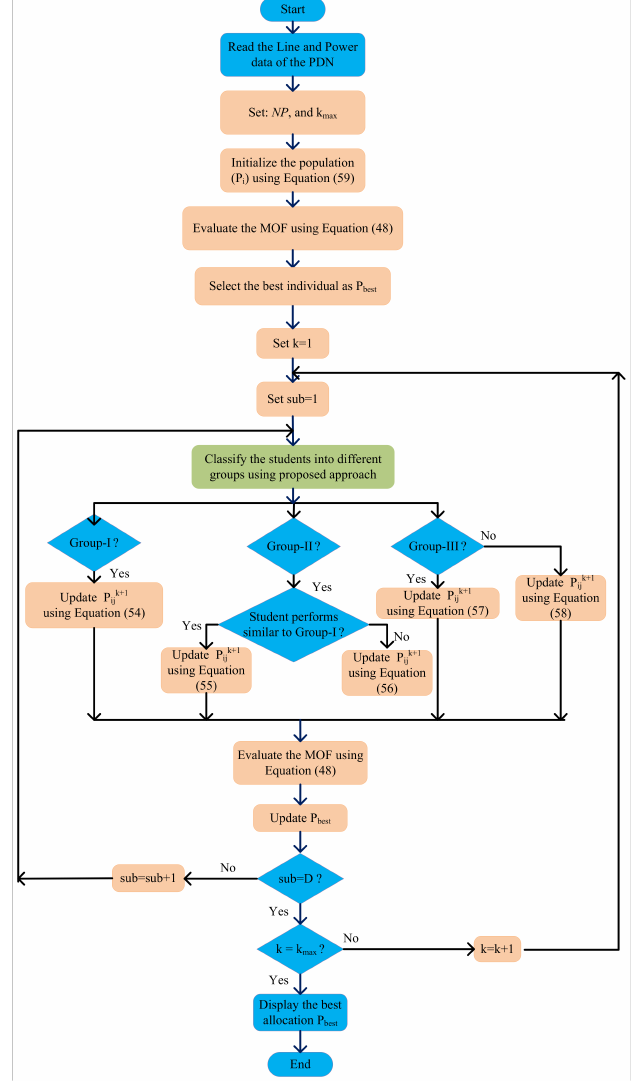
Figure 6. Flow Chart for implementing SPBO for